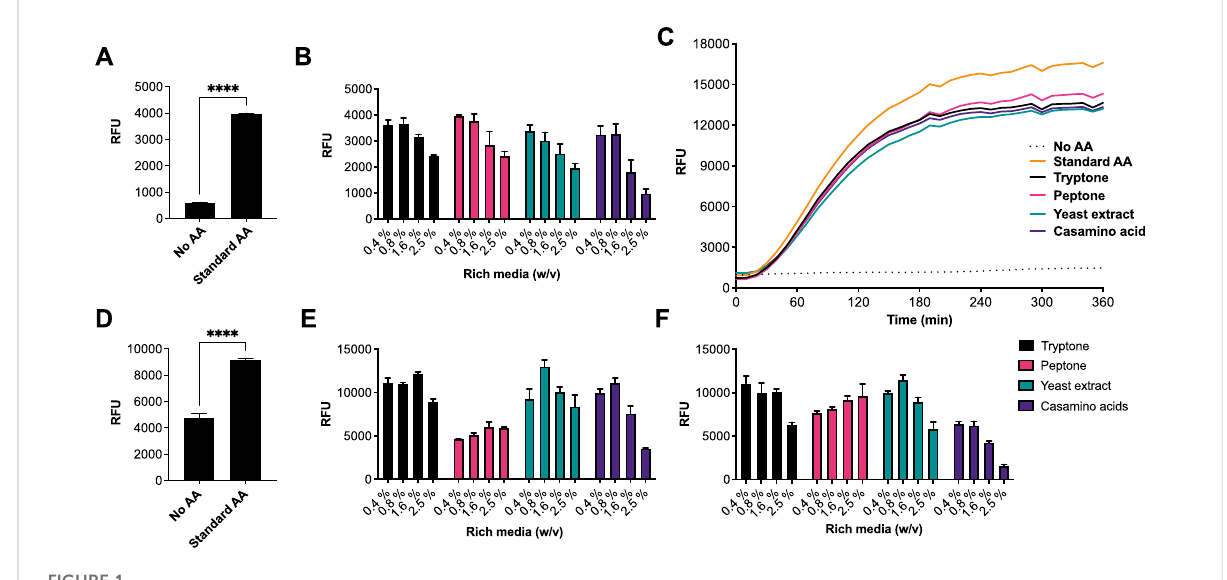
FIGURE 1 CFEactivityof E.coli Rosetta TM 2(DE3)andBL21(DE3)systemswithAAsubstitutes. (A) End-point fl uorescencemeasurementsof E.coli Rosetta ™ (DE3) 2 control reactions with no AAs and 1 mM of AA standard (See methods). (B) End-point fl uorescence measurements of E. coli Rosetta ™ (DE3) 2 reactions. (C) E. coli Rosetta ™ (DE3) 2 time-course reaction. (D) End-point fl uorescence measurements of E. coli BL21 (DE3) control reactions with no AAs and 1 mM of commercial standard (Sigma). (E) End-point fl uorescence measurements of E. coli BL21 (DE3) reactions with rich media commercial batch A, see Supplementary Table S1. (F) End-point fl uorescence measurements of E. coli BL21 (DE3) reactions with rich